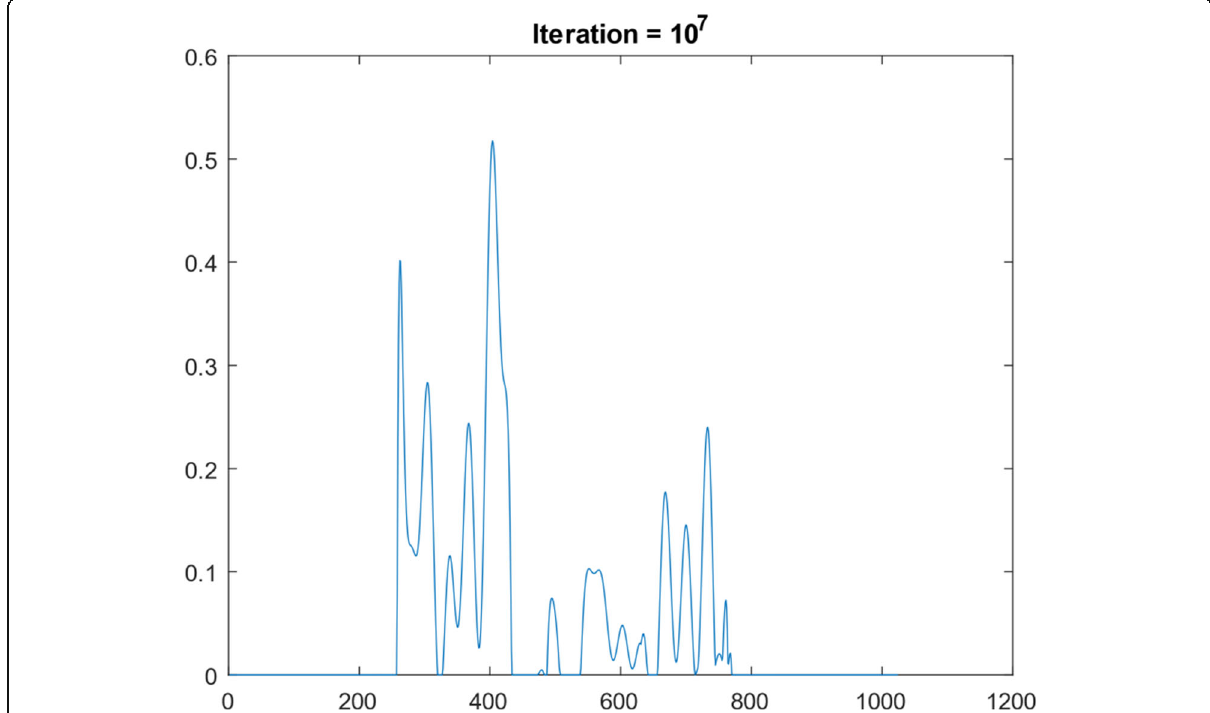
Fig. 8 Restored the ‘ random ’ function after 10 7 iteration of suggested algorithm